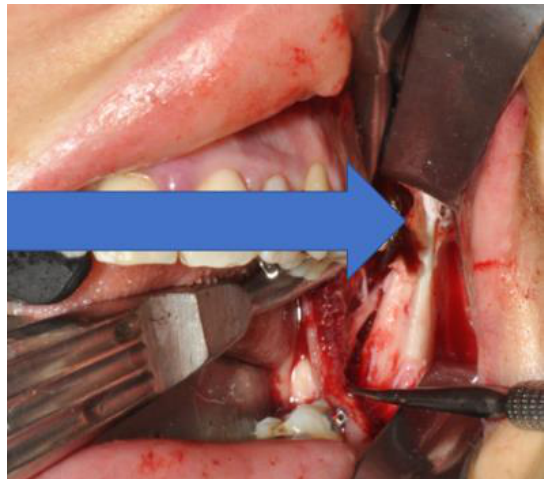
Figure 18. Intraoral approach for coronoidectomy. (Intraoral photographs for visualization purposes, from another case). A blue arrow marks the cutting direction for cutting the coronoid process of the mandible.